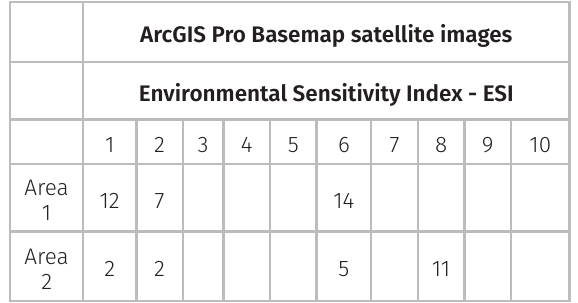
Table V. Number of segments observed in each ESI class, using ArcGIS Basemap satellite images for ESI mapping for oil